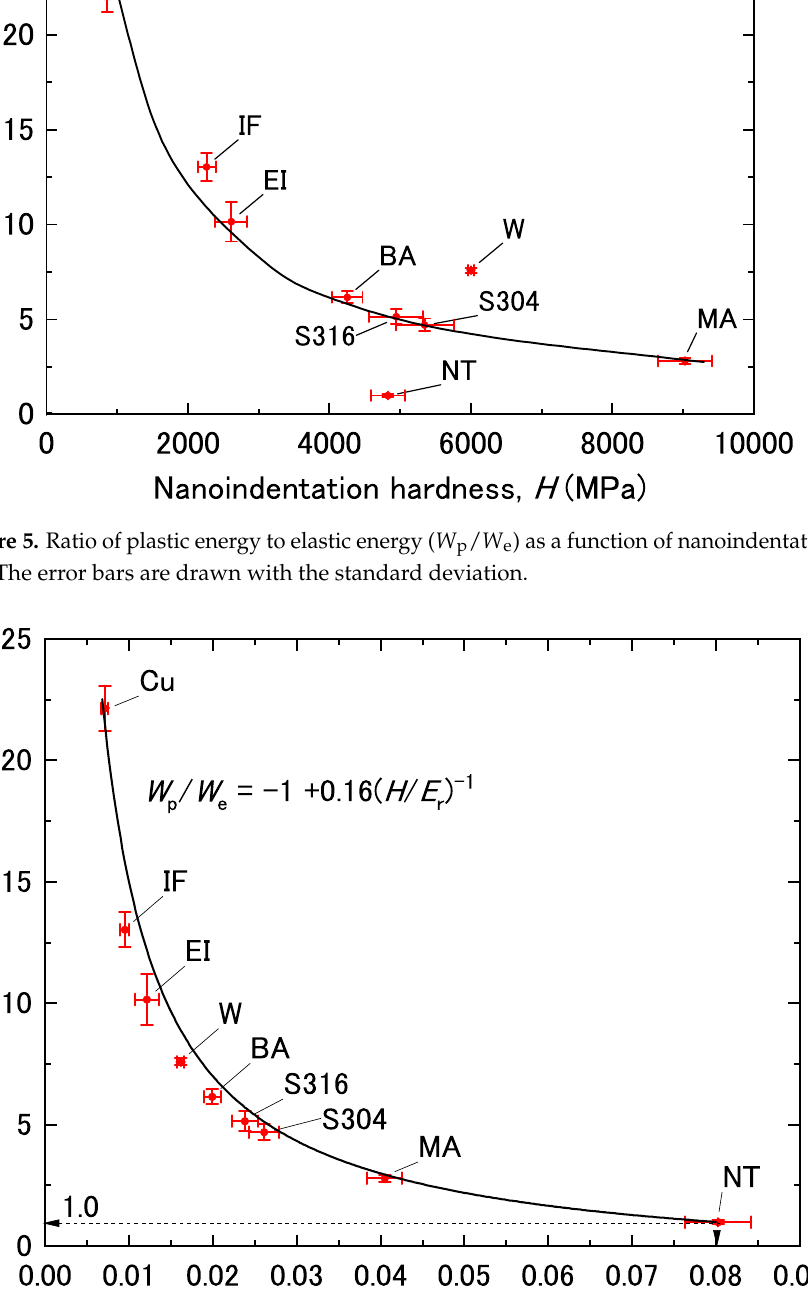
Figure 6. Ratio of plastic energy to elastic energy ( W p / W e ) as a function of the ratio of nanoindenta- tion hardness to reduced modulus ( H / E r ). The error bars are drawn with the standard deviation.